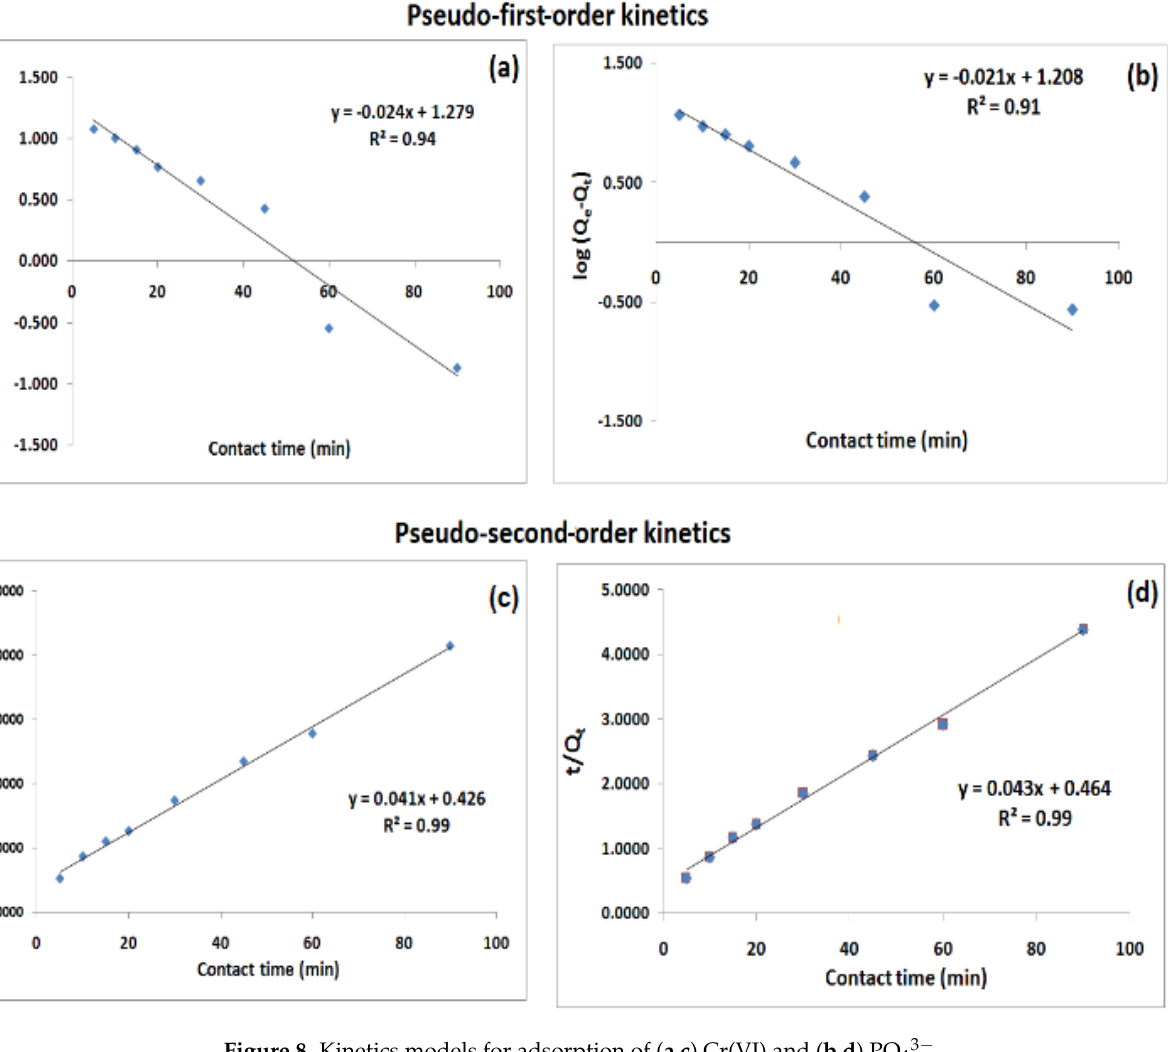
Figure 8. Kinetics models for adsorption of ( a , c ) Cr(VI) and ( b , d ) PO 4 3− . Table 2. Kinetics of